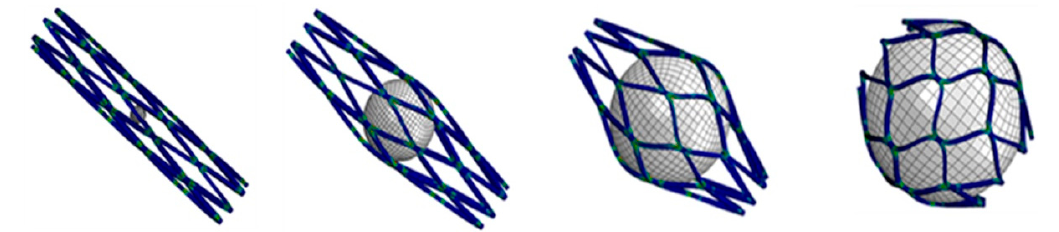
Figure 7. Contour plots of strain distribution during a series of expansions.